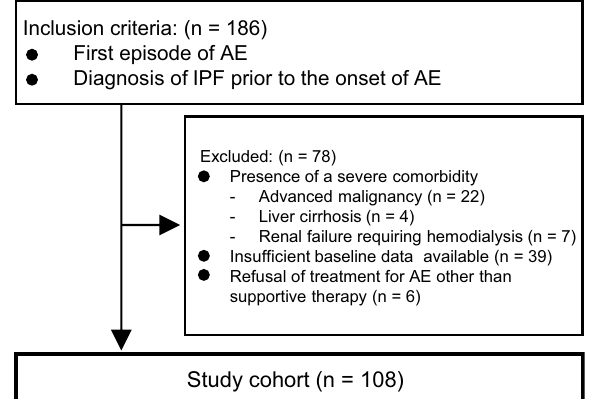
Figure 1. Flow diagram of patient selection. AE acute exacerbation, IPF idiopathic pulmonary